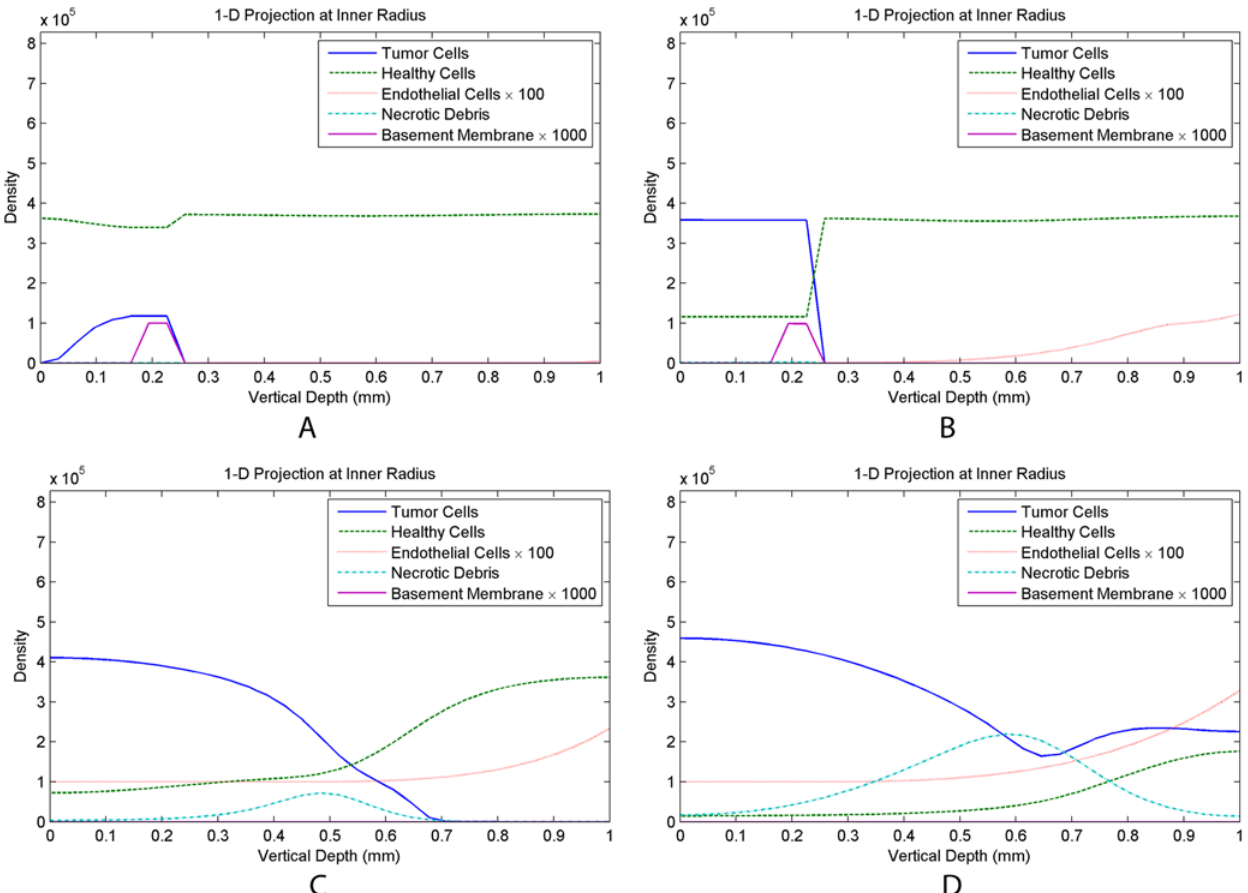
Figure 5. 1-D projection of variables densities at the inner radius of the domain. Time steps are evenly spaced over roughly 4.5 months of invasion under the basic model. (A) The seed of a tumor has been planted at the base of the epidermis. (B) The tumor has expanded vertically into the upper epidermis, and has increased in density due to cancer cells out-competing the healthy cells. (C) Here, the basement membrane has been eliminated, and the tumor invades vertically into the existing tumor-associated vasculature. (D) A significant necrotic core has formed roughly in the center of the vertical domain, very few healthy cells remain, and cancer cells continue to grow into the tumor vasculature.